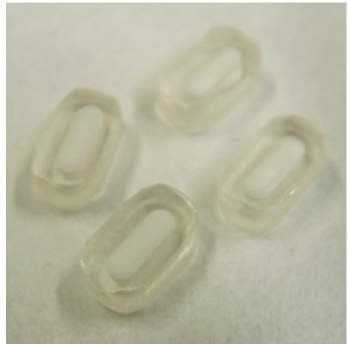
Figure 1. Photograph (top view) of four oblong pre-F-containing core-shell implants (approximately 5 × 9 mm). The core (approximately 25 mg) consisted of a physical mixture of freeze-dried pre-F-containing powder (24 wt %) and mannitol (76 wt %). The shell consisted of PLGA.